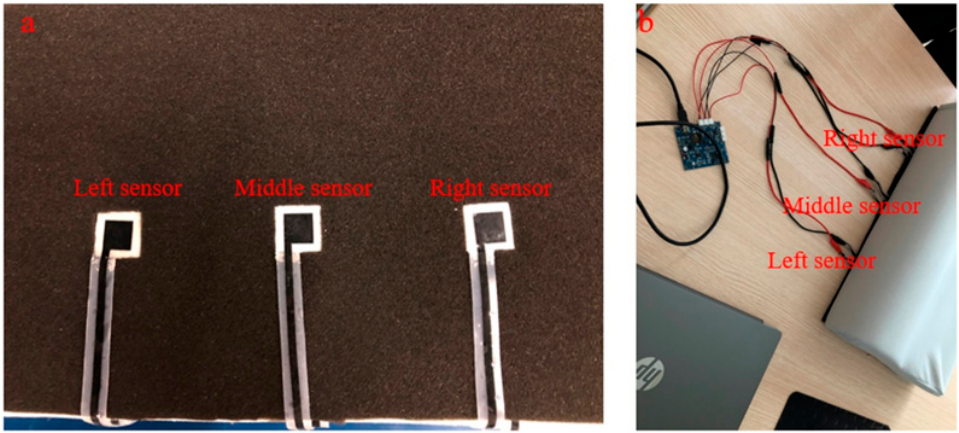
Figure A7. ( a ) Three flexible sensors on the pillow, ( b ) the test circuit diagram of our smart pillow.